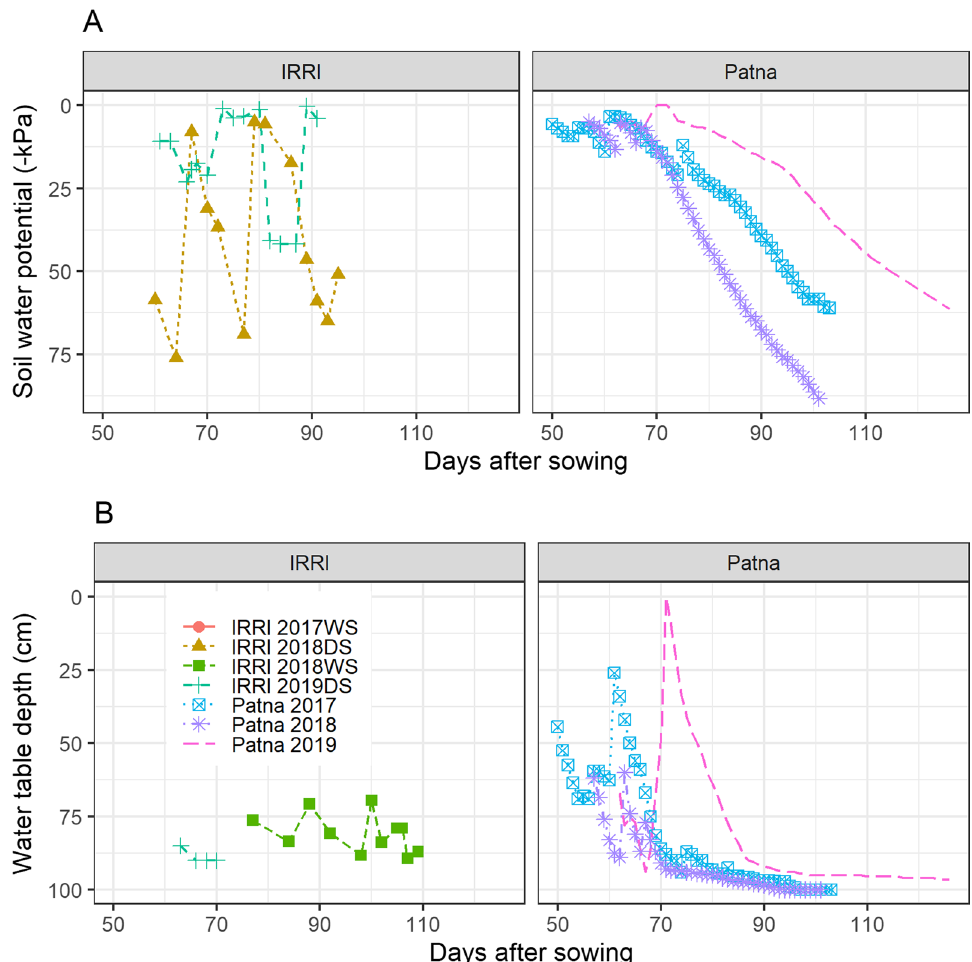
Fig. 1 Drought stress characterization across experiments. A Soil water potential at a depth of 30 cm as measured by tensiometer, B water table depth. Drought stress treatments were initiated at 57–62 days after sowing at Patna and 43–49 days after sowing at